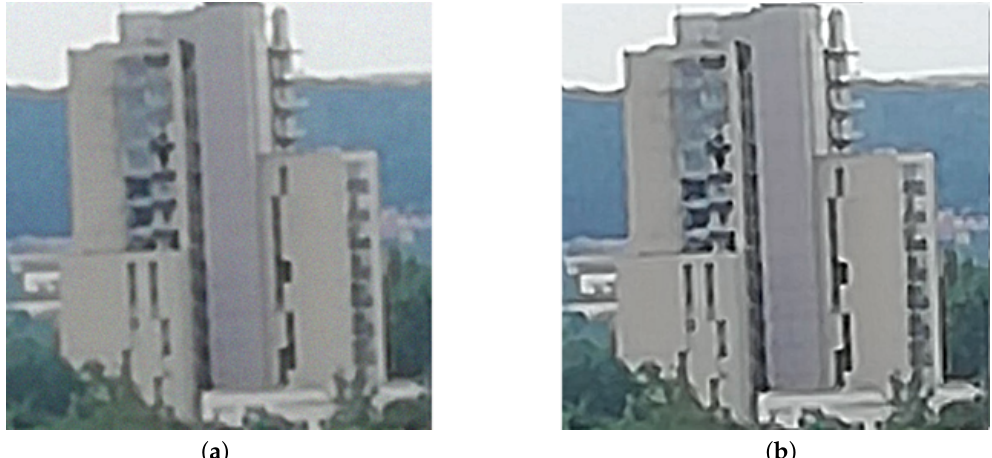
Figure 2. ( a ) Original and ( b ) color image of increased contrast between individual areas.